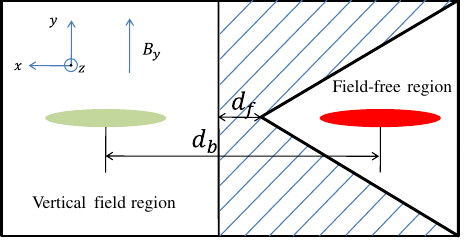
FIG. 3. Transverse cut of septum magnet (not to scale). The shaded area is the material to shield the magnetic fields. The red and green ellipses are the electron beams. This septum as shown here is used to delay the low-energy bunch (left